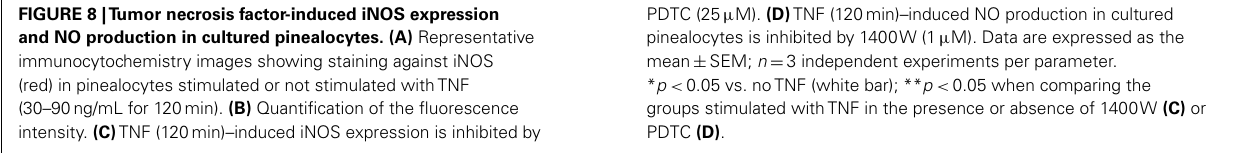
PDTC (25 μ M). (D) TNF (120min)–induced NO production in cultured pinealocytes is inhibited by 1400W (1 μ M). Data are expressed as the mean ± SEM; n = 3 independent experiments per parameter. * p < 0.05 vs. noTNF (white bar); ** p < 0.05 when comparing the groups stimulated withTNF in the presence or absence of 1400W (C) or PDTC (D)